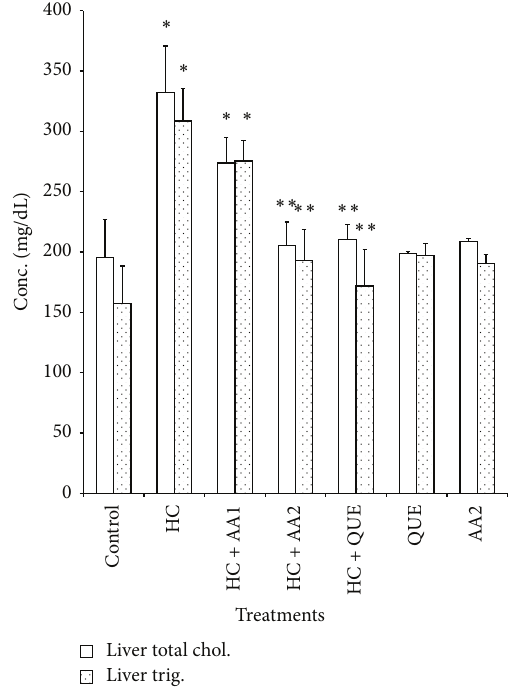
Figure 2: Effects of methanol extract of Artocarpus artilis and Questran on hepatic total cholesterol and triglyceride levels of hypercholesterolemic rats. ∗ Significantly different from control ( 𝑃 < 0.05 ), ∗∗ significantly different from HC ( 𝑃 < 0.05 ). HC: hyper- cholesterolemic rats, AA1: Artocarpus altilis at 100mg/kg, AA2: Artocarpus altilis at 200 mg/kg, and QUE: Questran at 0.26 g/kg.